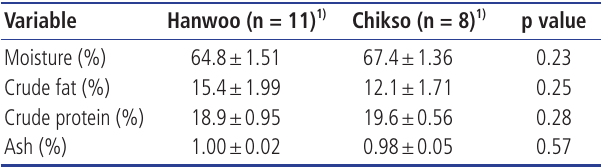
Table 1. Proximate composition of strip loin from Hanwoo and Chikso steers finished under same diet